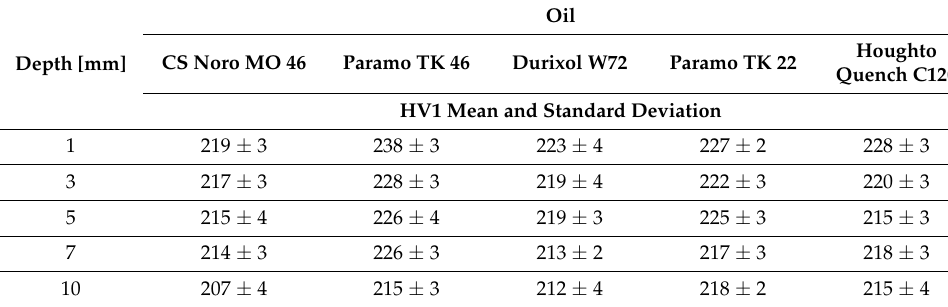
Table 2. Hardness profile mean value and deviation for individual